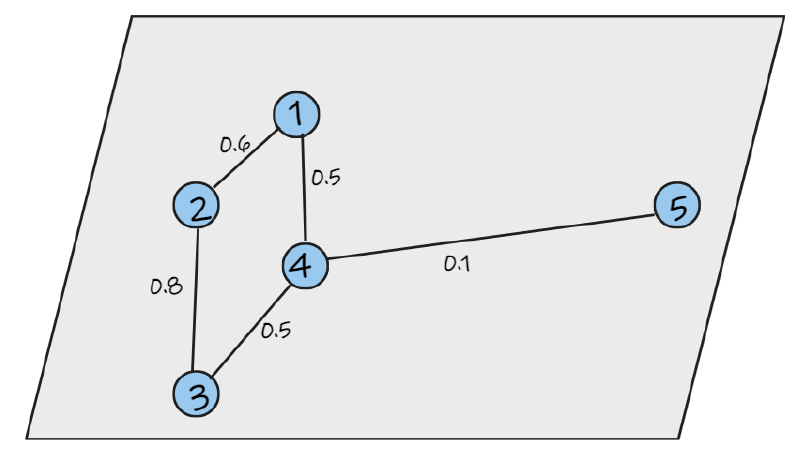
Figure 2. Example of an arbitrary sector. Nodes represent the aircraft in the